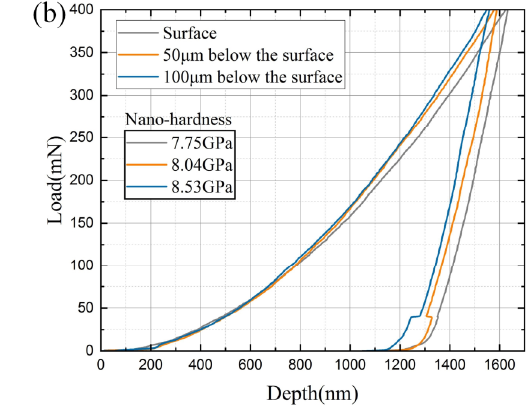
Figure 9. Nano-hardness of the gear surface layer: ( a ) nano-hardness of normal tooth; ( b ) nano- hardness of tooth after tempered grinding burns.